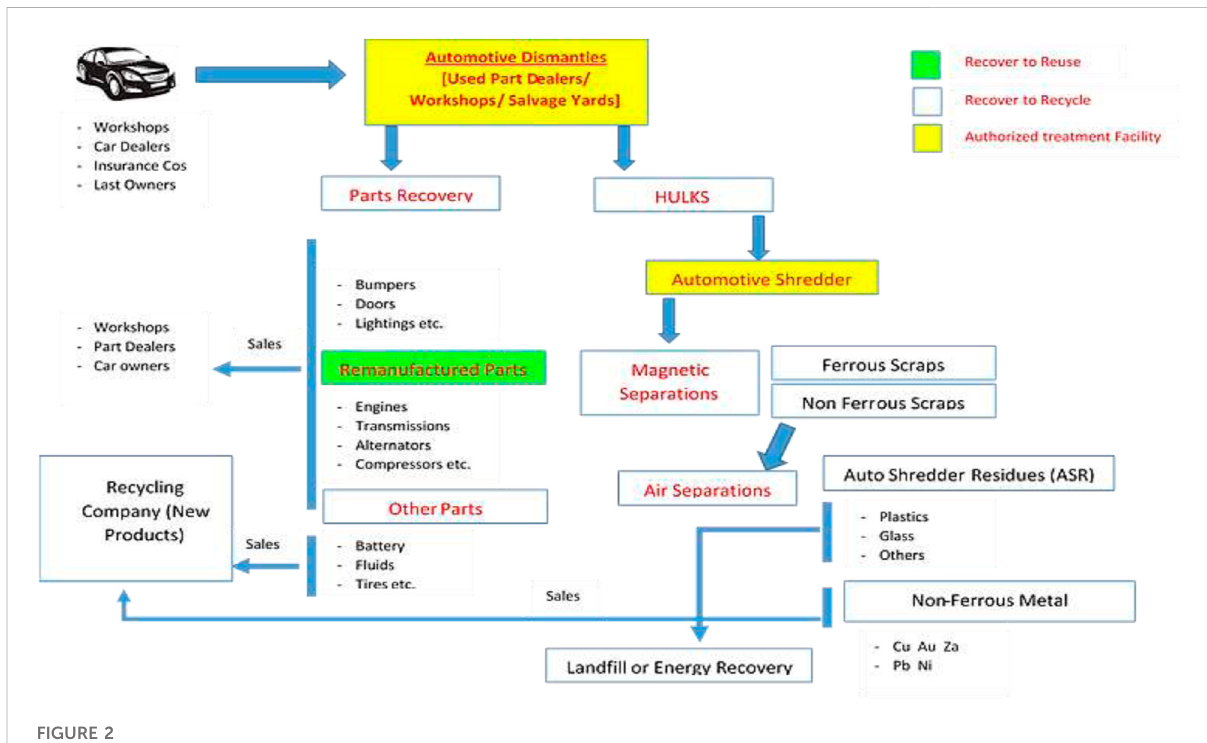
FIGURE 2 End of live vehicles recycling process (Jawi et al.,